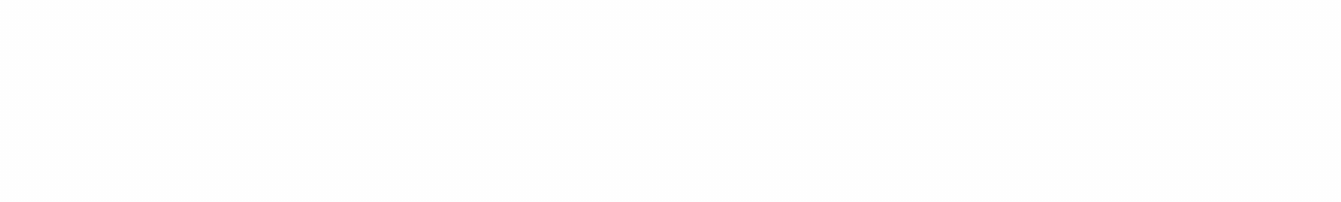
FIGURE 7 A trajectory of E with noise (c =0.33, cr =0.05). FIGURE 9 The attractor in E-Y plane with noise (c 0.33, a 0.05).